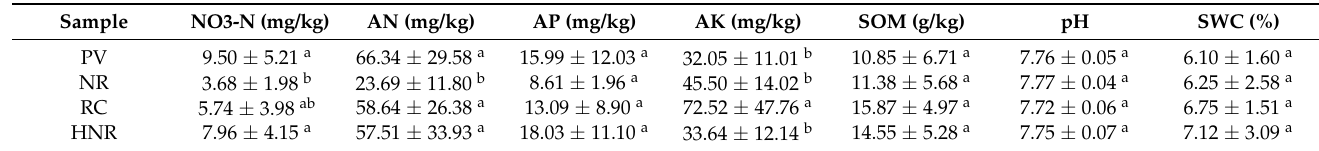
Table 1. Soil physicochemical properties under different